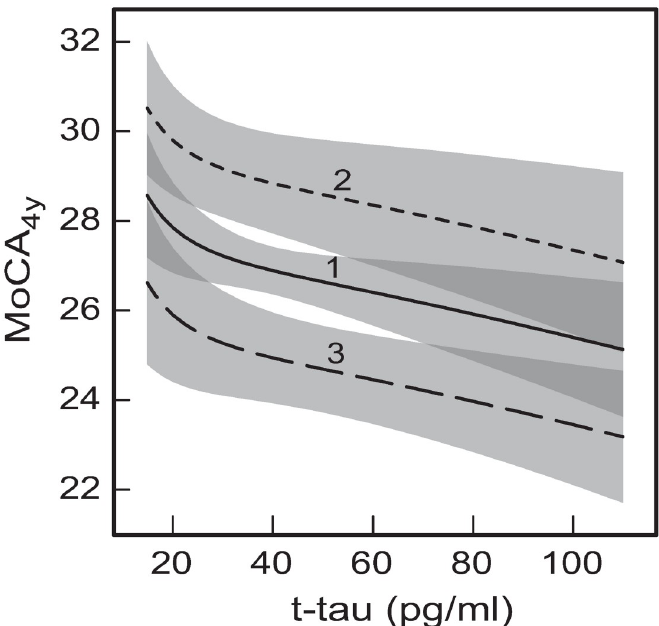
Fig 5. The predicted dependences of MoCA 4y on baseline CSF concentration of t-tau. The dependences result from the total effects of t-tau on MoCA 4y in either of the two GSEM networks for the following baseline ages: (1) Age = 60 years; (2) Age = 40 years; (3) Age = 80 years. The shaded bands indicate the 95% prediction intervals for the respective curves. The darker shade areas indicate overlaps of the prediction intervals for the neighboring curves. The other measures having direct effects on MoCA 4y were taken at their mean values: MoCA b = 27, UPDRS 1-3 = 31.87, GDS = 2.30, and average (A β 1–42 ) 1/2 = 18.95 (A β 1–42 = 359.10 pg/ml), α -syn was predicted from (A β 1–42 ) 1/2 and ln(t- tau), as per the developed